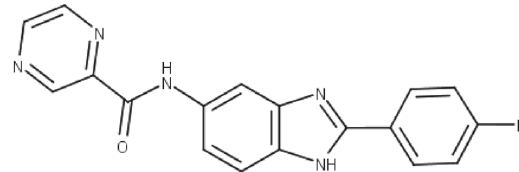
FIGURE 26 - Structure of the compound PubChem ID 47037197.